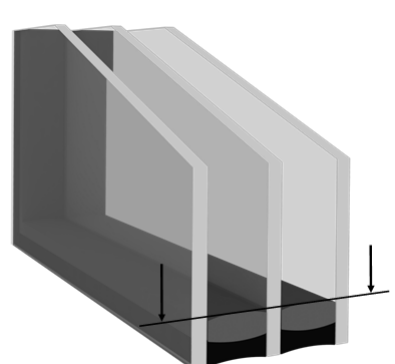
Fig. 4 Exact Alignment of the two frames with Ködispace 4SG